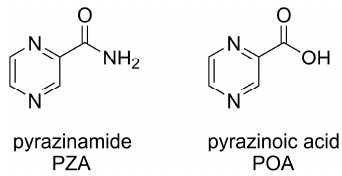
Figure 1. Structures of pyrazinamide and its active form, pyrazinoic acid.